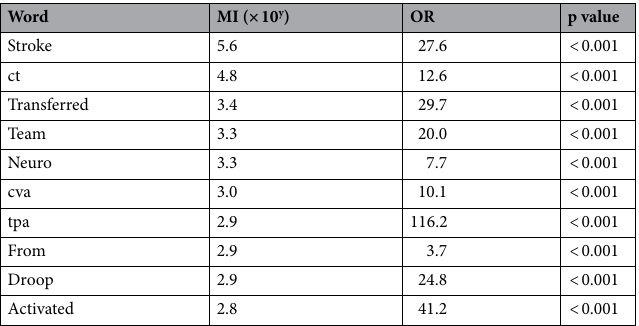
Table 2. Words with 10 highest mutual information values with NSICU admission and associated odds ratios. All words are from clinician and nursing notes. NSICU neurosciences intensive care unit, MI mutual